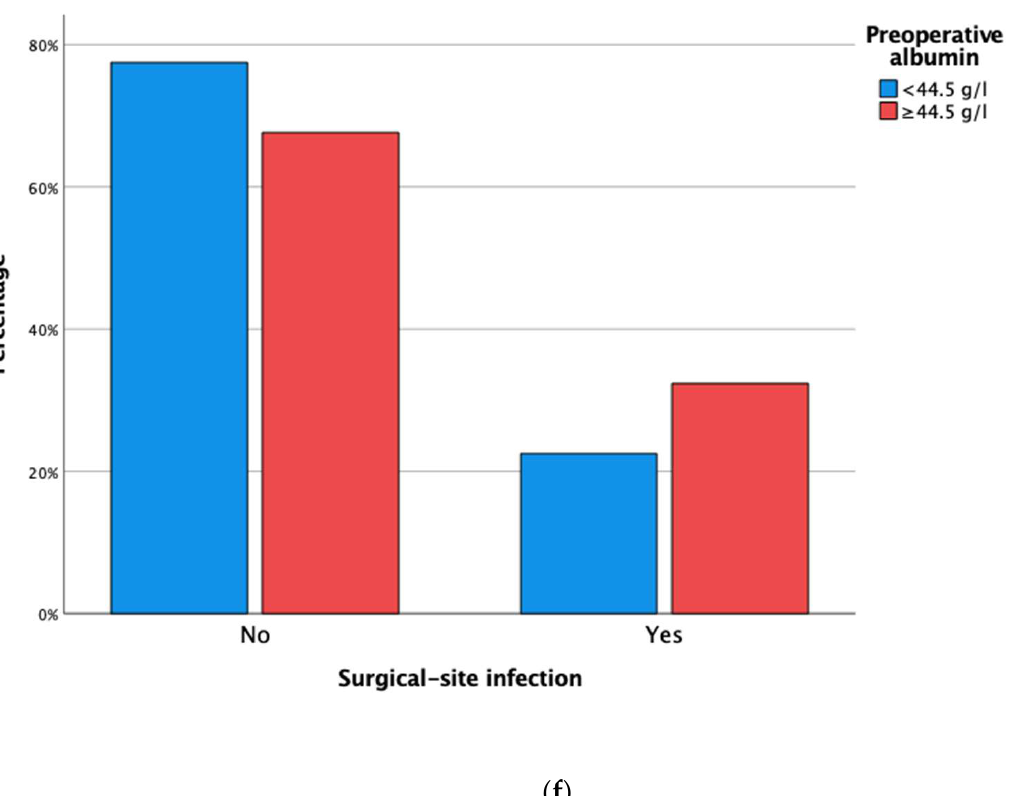
Figure 1. Clustered bar charts for overall complication, major complication, delayed gastric emptying, postoperative pancreatic fistula, hemorrhage, and surgical site infection comparing patients based on preoperative serum albumin value. ( a ) Overall complication ( p = 0.011); ( b ) Major complications ( p = 0.250); ( c ) Delayed gastric emptying ( p = 0.1); ( d ) Postoperative pancreatic fistula ( p = 0.824); ( e ) Hemorrhage ( p = 0.210); ( f ) Surgical-site infection ( p = 0.507).